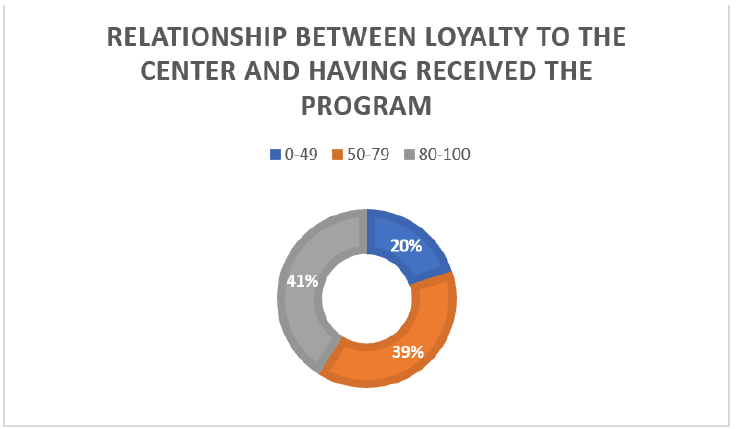
Figure 3. Influence of the program on the decision to become loyal to the center on a scale of 0 to 100.